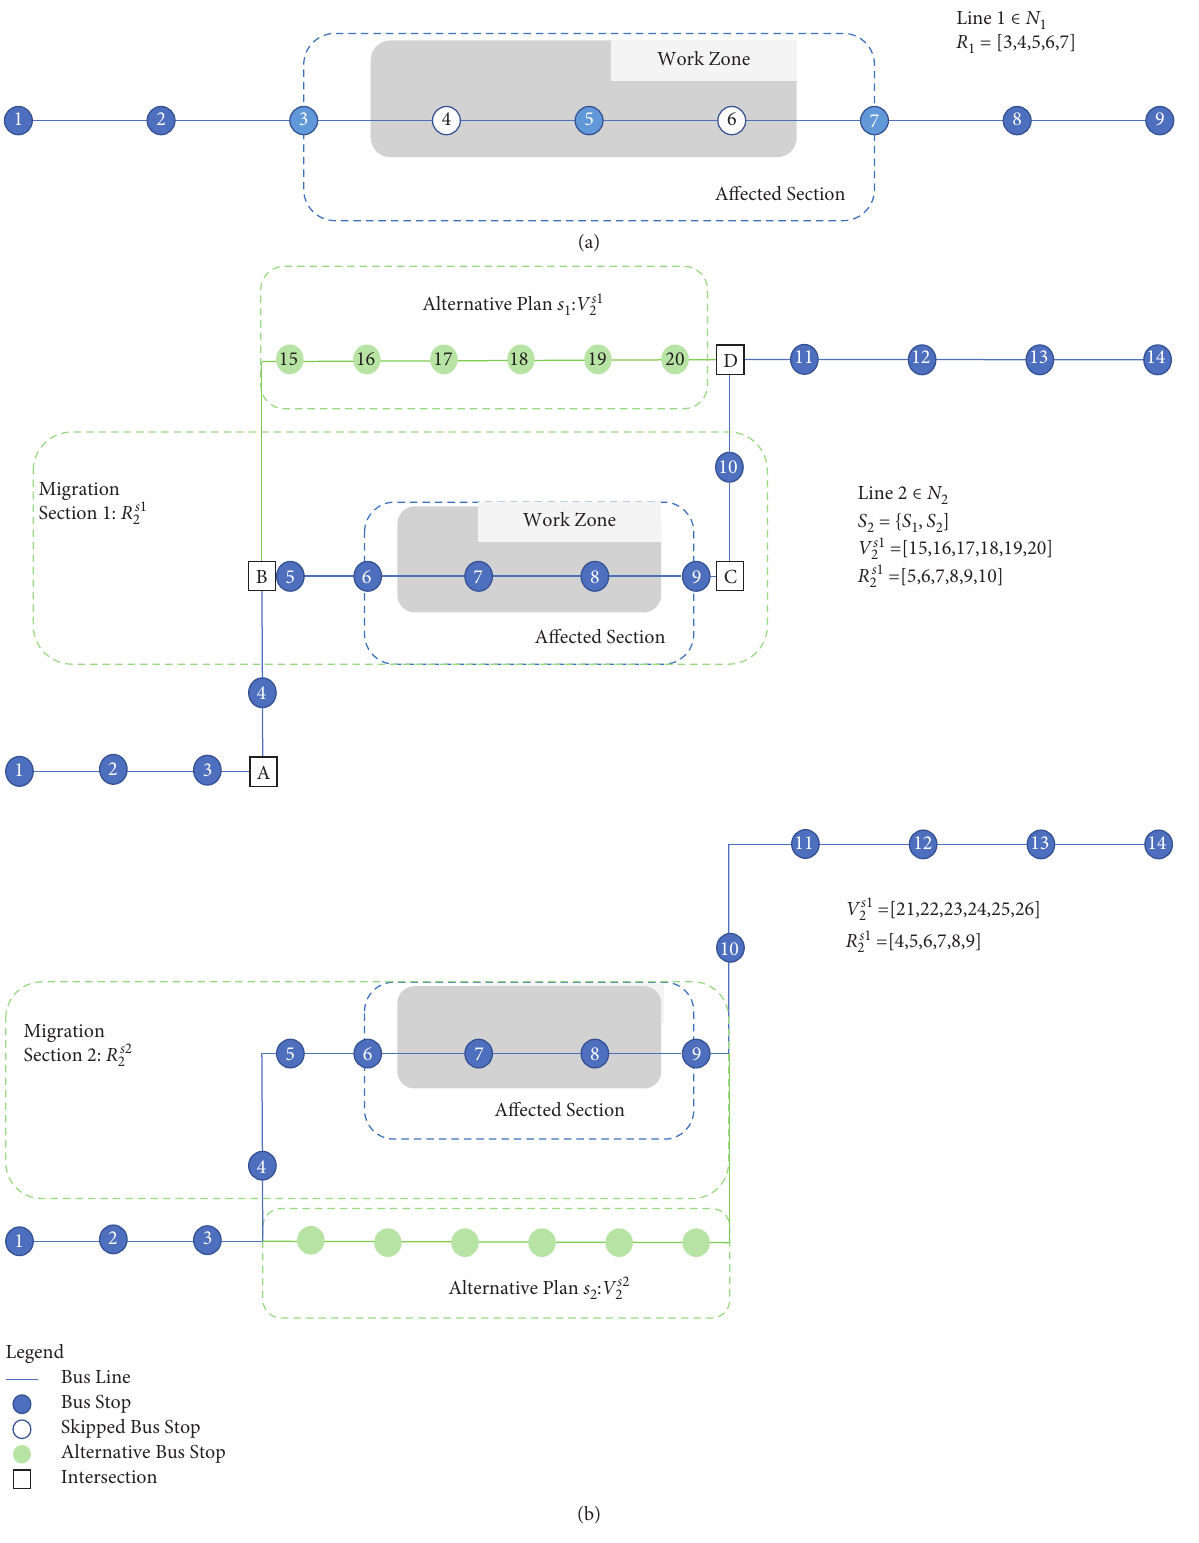
Figure 3: Illustration of the two adjustment patterns. (a) Stop-Skipping pattern and (b) Migration